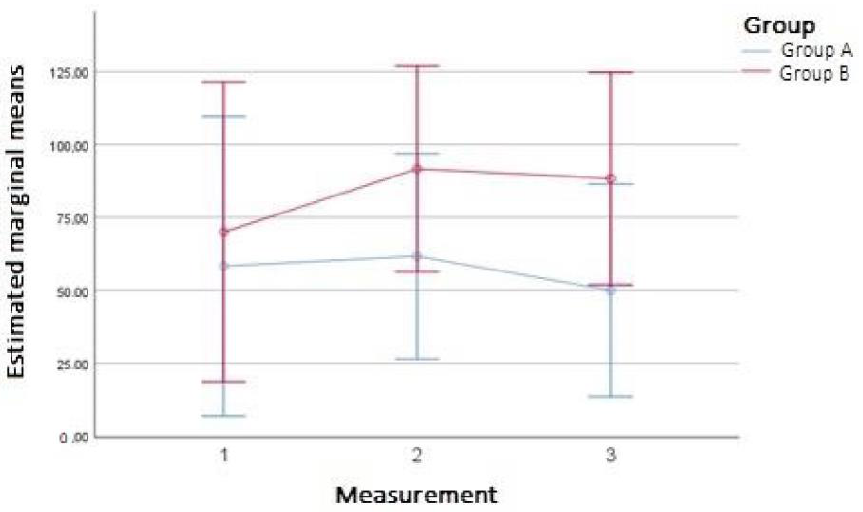
Figure 3. Graph presenting changes in SF-physical functioning in groups A and B over time: measurement 1 (baseline), measurement 2 (after 4 weeks), measurement 3 (after 6 weeks).